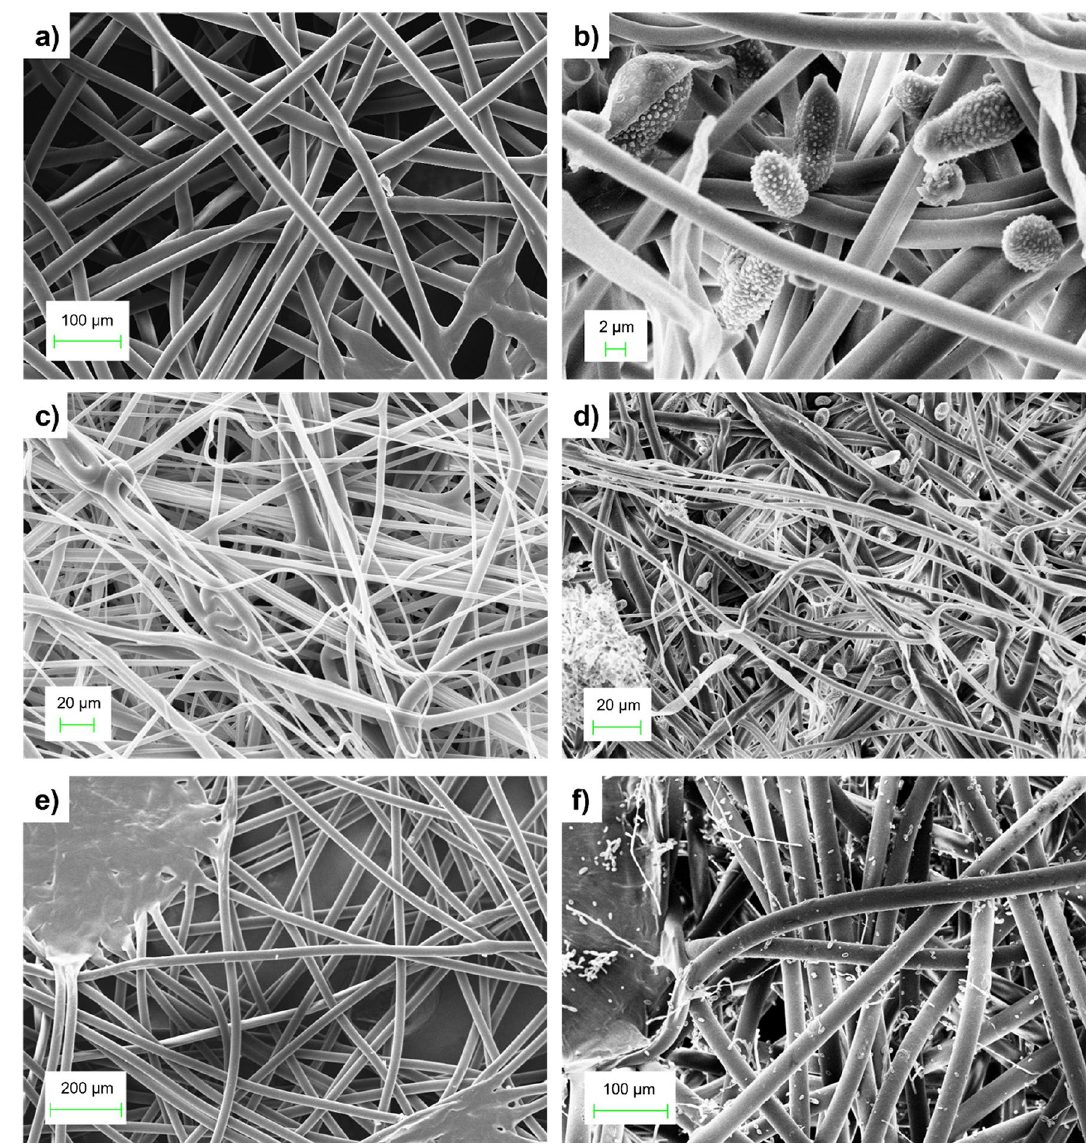
Figure 3. Layer-by-layer SEM comparison of a FFP2 facemask, before and after a 24-h usage: ( a ) Inner layer, before wearing, ( b ) Inner layer, after 24 h, ( c ) Middle layer, before wearing. ( d ) Middle layer, after 24 h, ( e ) Outer layer, before wearing, and ( f ) Outer layer, after 24